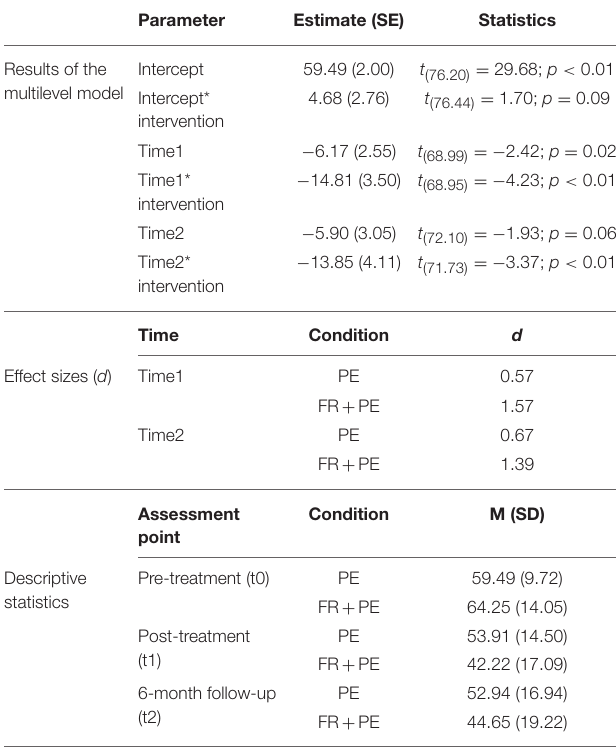
TABLE 2 | Results for the primary outcome stress-level measured with the global scale of the “Perceived Stress Questionnaire” (PSQ). Parameter Estimate (SE) Statistics Results of the Intercept multilevel model